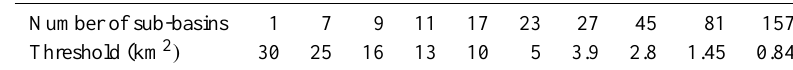
Table 1. Area threshold for watershed division.